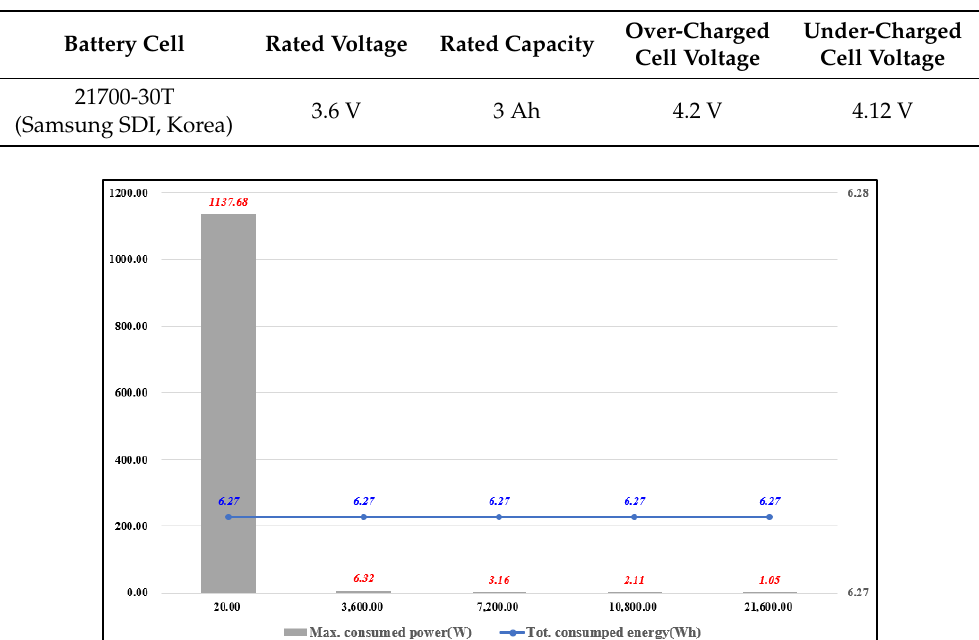
Table 7. Specifications of the battery used in the analysis.